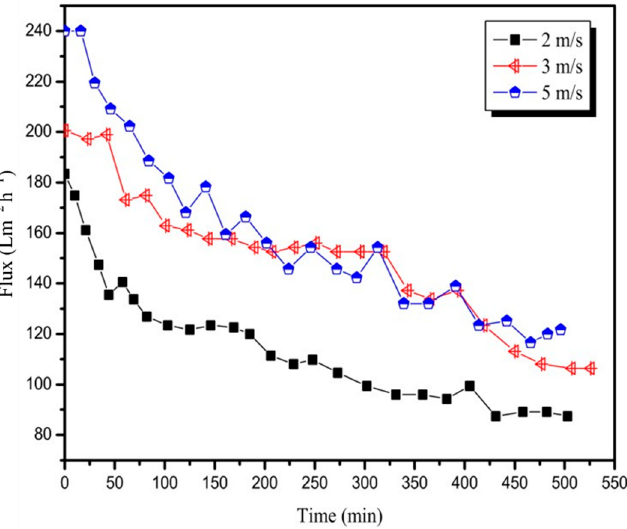
Figure 4. Variation in permeate flux with time for the 20 nm membrane at CFVs (T = 90 °C, TMP = 3 bar).